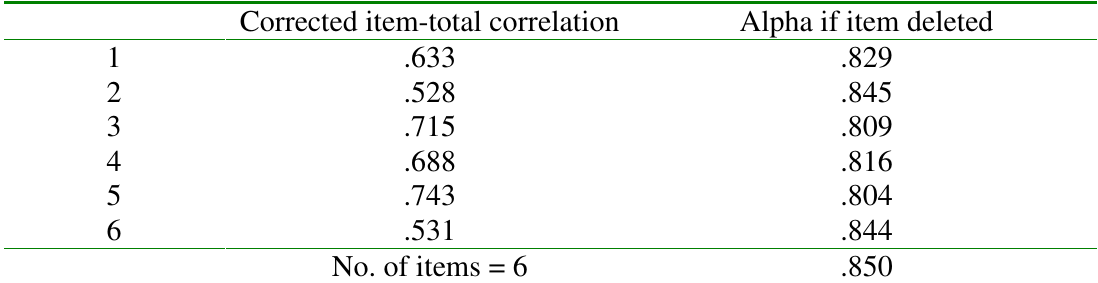
Reliability Analysis of the Six Tasks (N = 90)